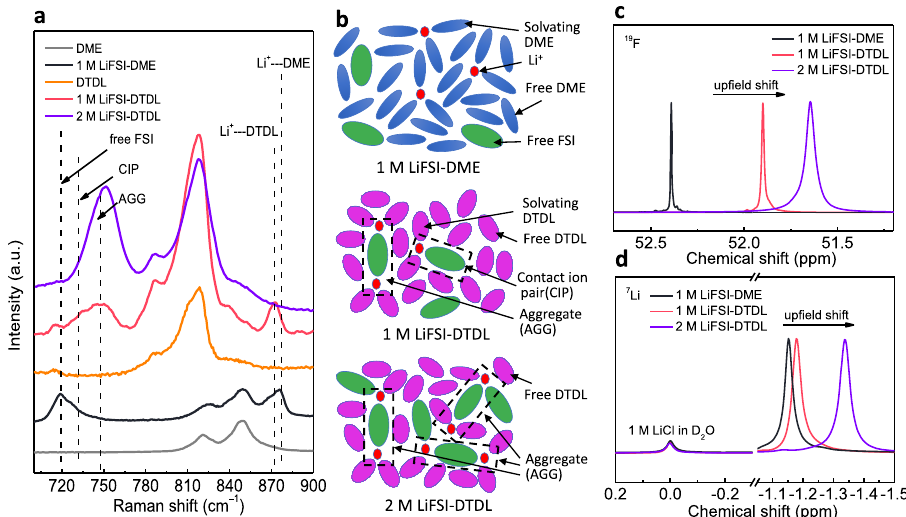
Fig. 5 Electrolyte solvation structure analysis. a Raman spectra of solvents and electrolytes. b Schematic diagrams of Li + coordination structures in different electrolytes. NMR spectra of 19 F ( c ) and 7 Li ( d ) of different